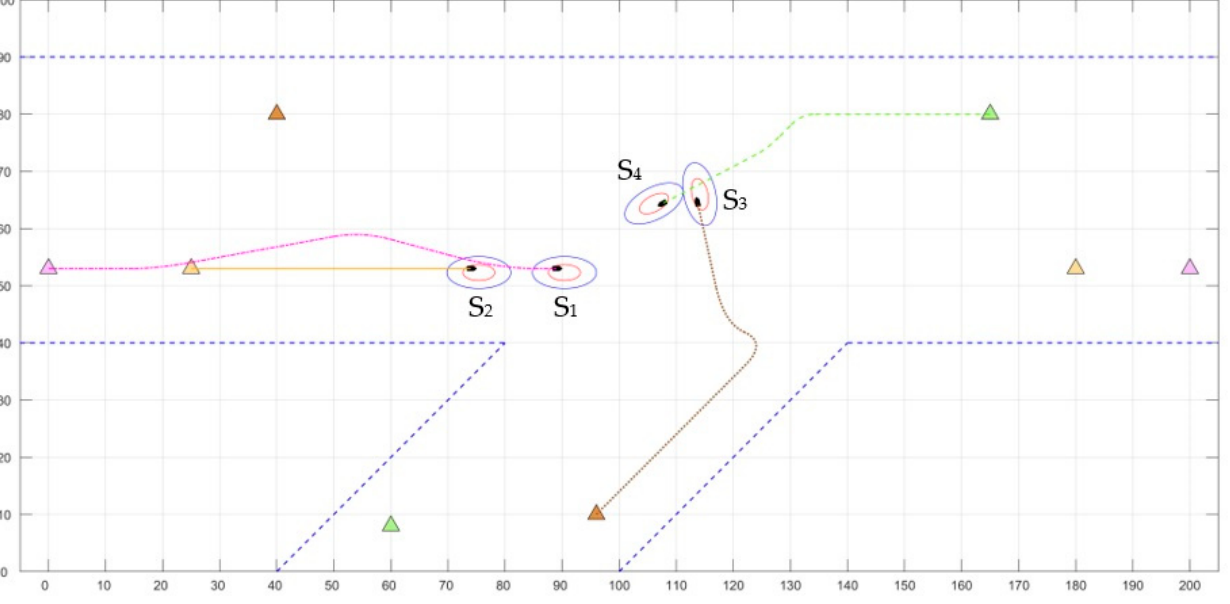
Figure 18. Scenario III of collision avoidance in a multi-ship situation.